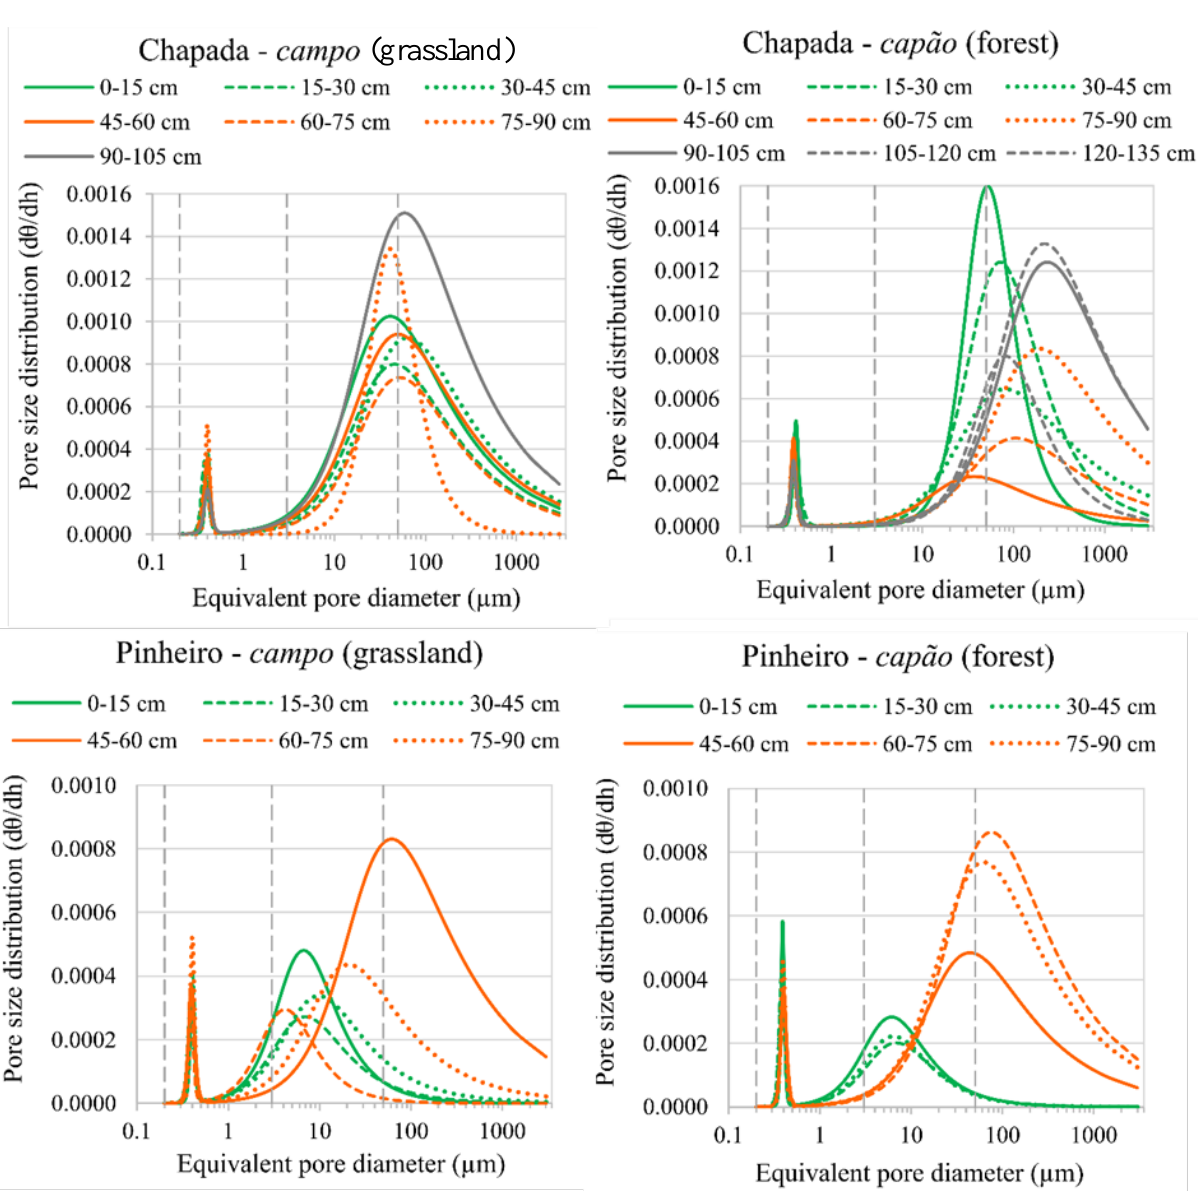
Figure 8. Continuous pore size distributions as given by the first derivative of the bimodal water retention curves for the evaluated layers from both peatlands (Chapada and Pinheiro) under forest ( campo ) and grassland ( capão ) vegetation. Vertical dashed lines indicate the limits between pore size classes (macropores